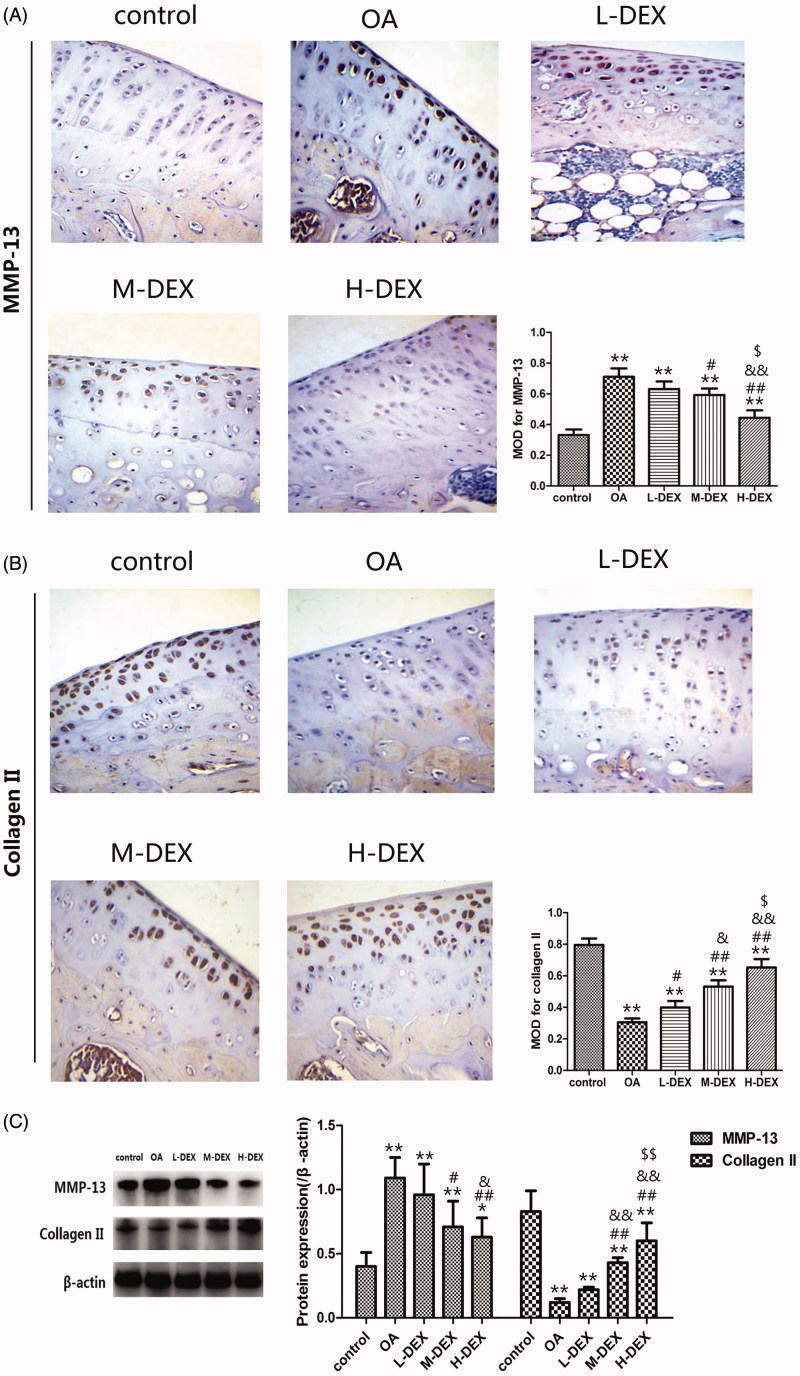
Effect of Dex on cartilage matrix metabolism in OA rats. (A) The expression of MMP-13 and collagen II expression in cartilage tissue was analyzed by immunohistochemistry after Dex treatment (×400). (B) Western blot analysis of expression of MMP-13 and collagen II in cartilage tissue. Values are means ± SD. N = 10. **p < 0.01 vs. control group; #p < 0.05, ##p < 0.01 vs. OA group; &p < 0.05, &&p < 0.01 vs. L-DEX group; $p < 0.05, $$p < 0.01 vs. M-DEX group.